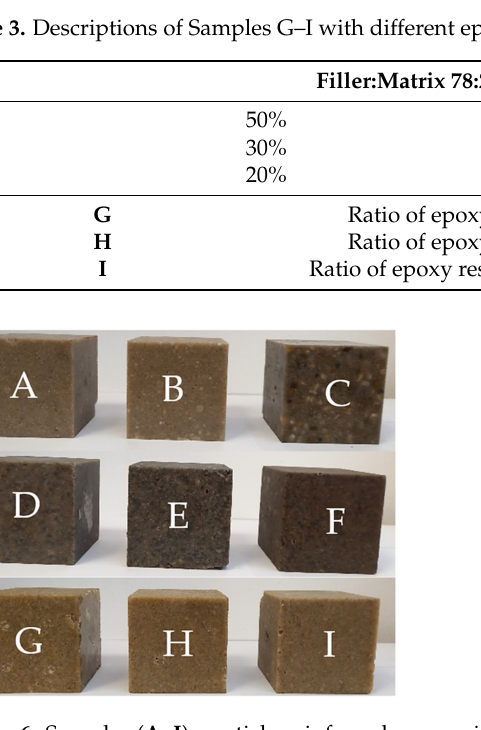
Figure 6. Samples ( A – I ), particle-reinforced composites, samples: ( A – C ) with different filler sizes (more in Table 1), ( D – F ) with different short fibre volume and same fillers (more in Table 2), and ( G – I ) with different epoxy resins and constant fillers mixture (more in Table